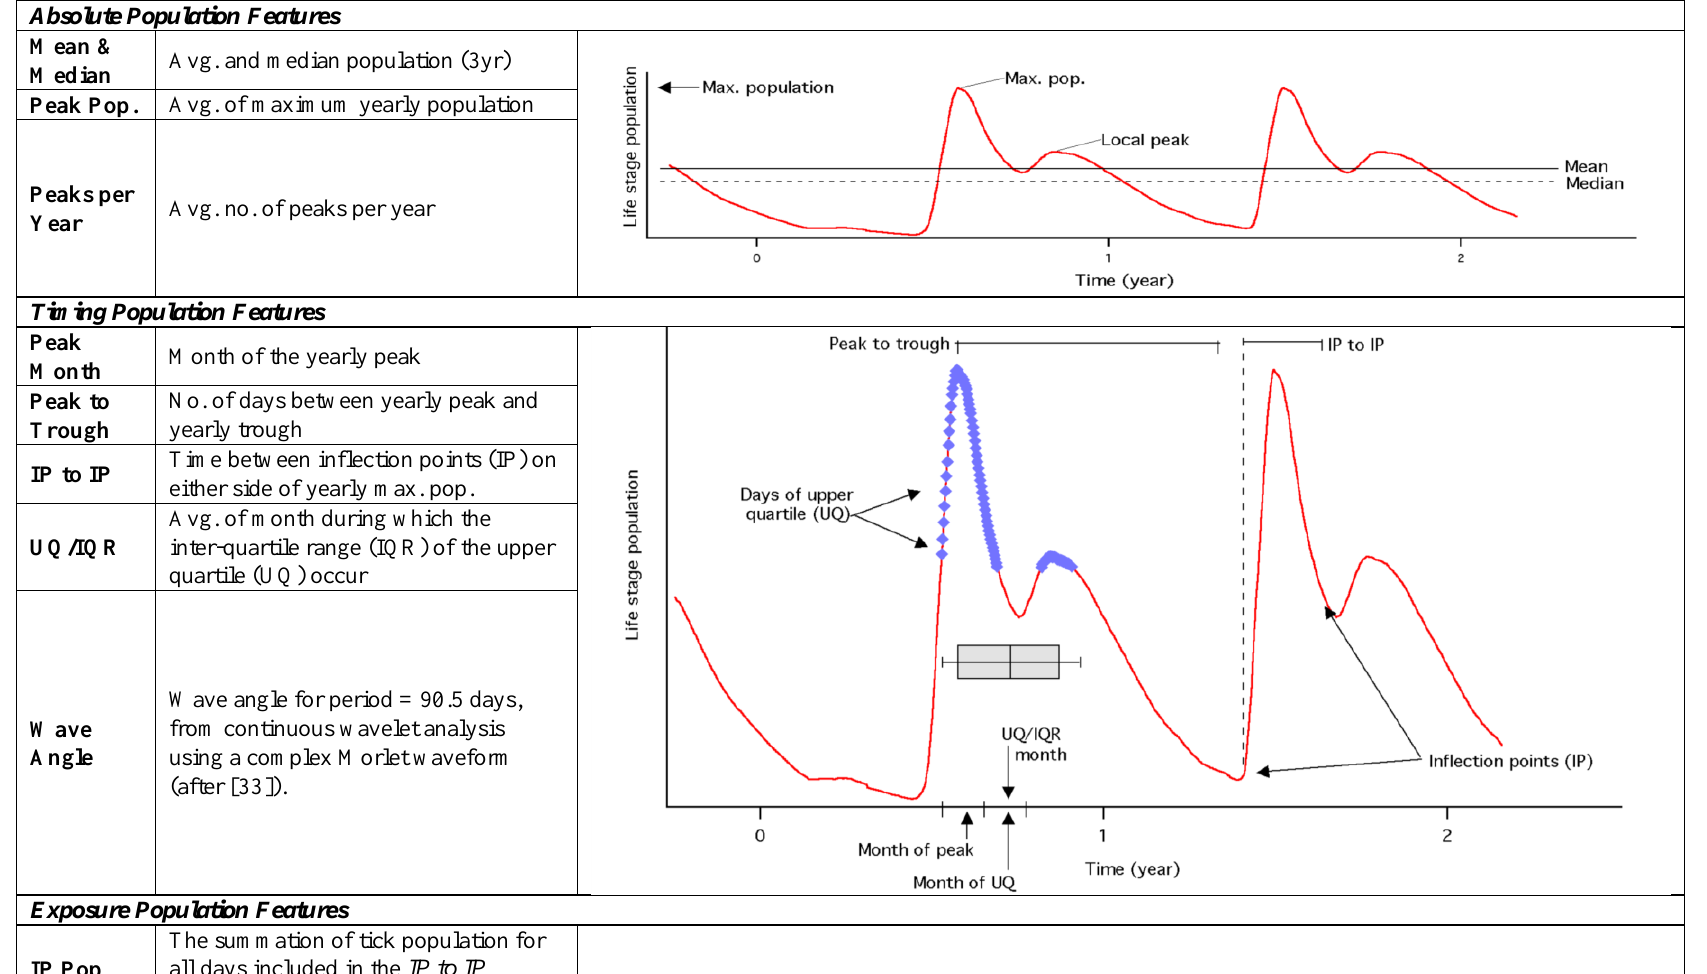
Table 1 . Dynamic population features (DPFs) of population